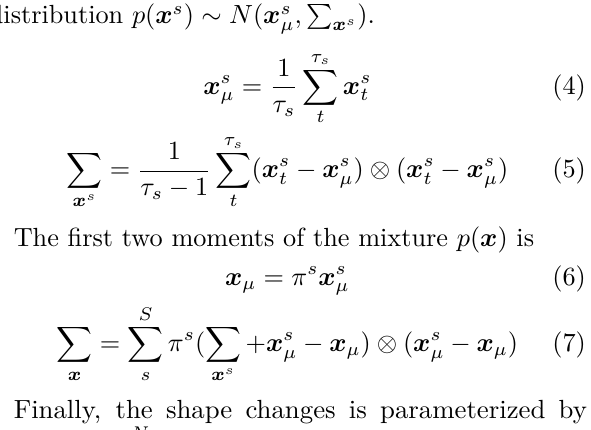
in exhalation state obeys Gaussian distribution (cid:2) (cid:2) p ( r s | r , ∼ N ( r , μ μ r ) r ) and deforms with